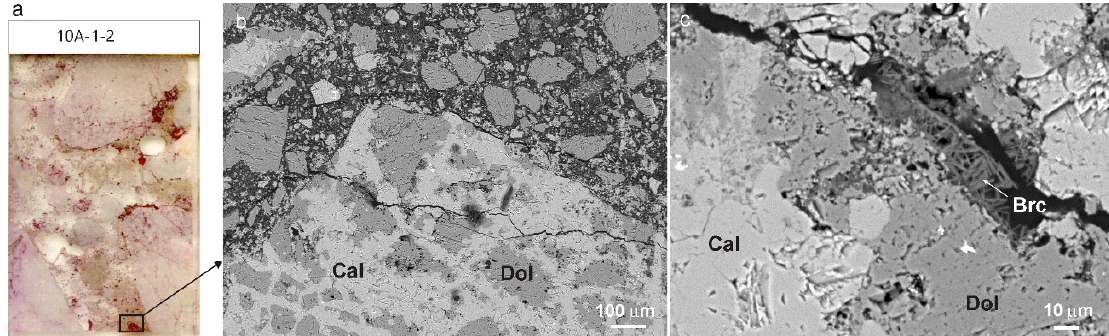
Figure 8. ( a ) Image of a thin section of type B concrete stained with red alizarin; ( b , c ) SEM images of the dolomite- and-cement paste contact in type B concrete with the development of fibrous brucite.